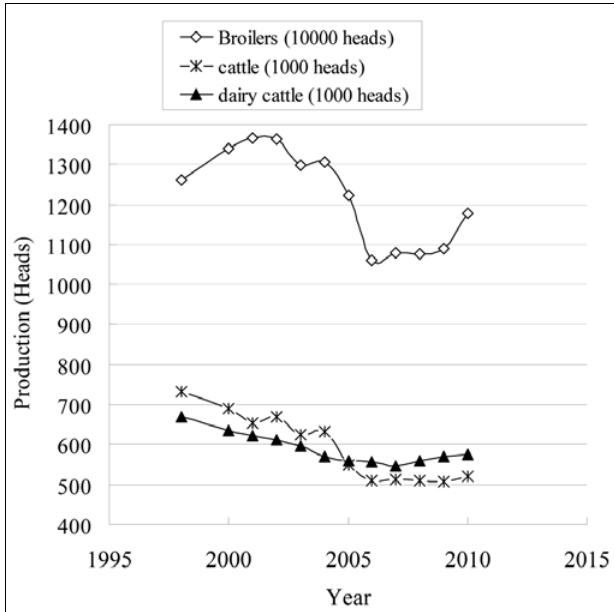
FIGURE 2 | Production of food animals in Denmark from 1998 to 2010 (data obtained from DANMAP, 2010).